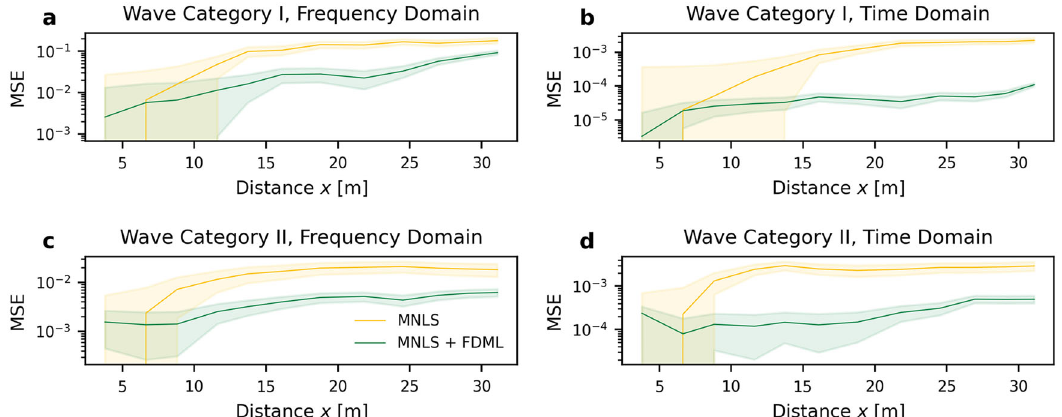
Fig. 5 Mean squared error (MSE) relative to the ground truth for the MNLS + FDML model compared to the MNLS model, averaged over all experiments from the test set (the set of data not used for training) that are breaking. The shaded region corresponds to ±1 standard error across cases. Data were shown for the full propagation length. Wave Category I in the time domain ( a ) and frequency domain ( b ) and Wave Category II in the time domain ( c ) and frequency domain ( d ). We plot the dimensional distance x on the horizontal axis, as the dimensionless distance ξ is different for each